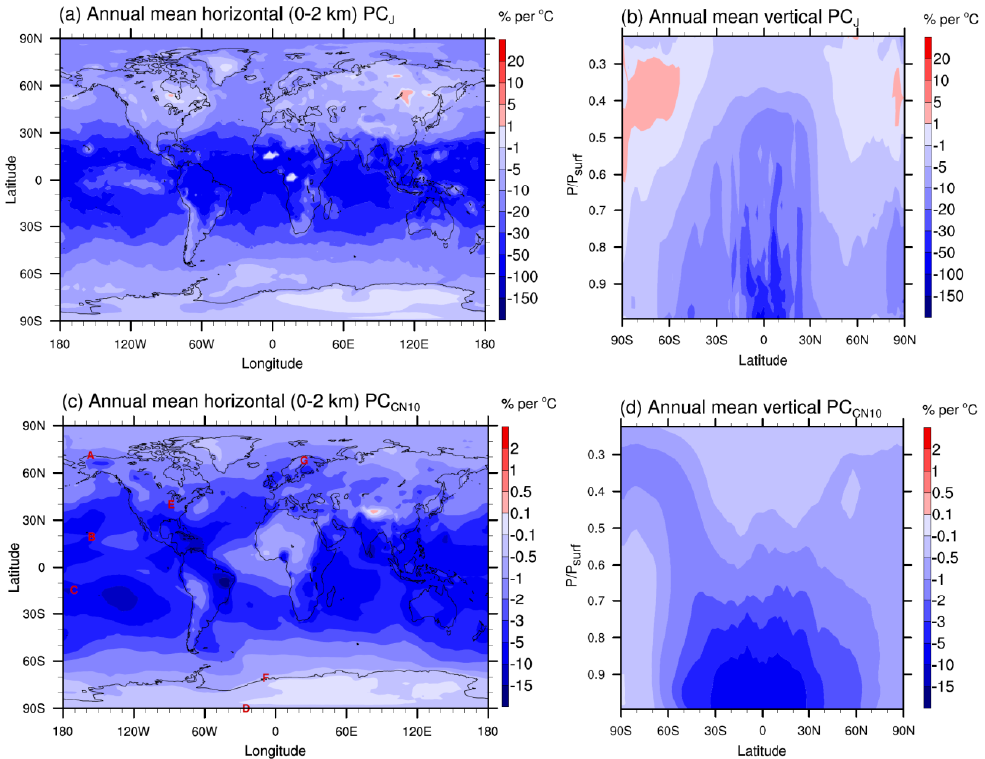
Figure 3. Fig. 3. Horizontal (i.e., averaged within the 0–2km surface layer) and vertical (i.e., zonally averaged) spatial distributions of the annual mean percentage changes in nucleation rates ( J ) and concentrations of condensation nuclei larger than 10nm (CN10), for a uniform 1 ◦ C temperature increase. These temperature sensitivities were calculated as described in the text. In panel (c) , the locations of four NOAA baseline stations (BRW, MLO, SMO, and SPO), one NOAA regional station (BND), and one German Antarctic station (NEU) are marked respectively as A, B, C, D, E, and F. The location of Pallas station discussed in Supplement is marked as